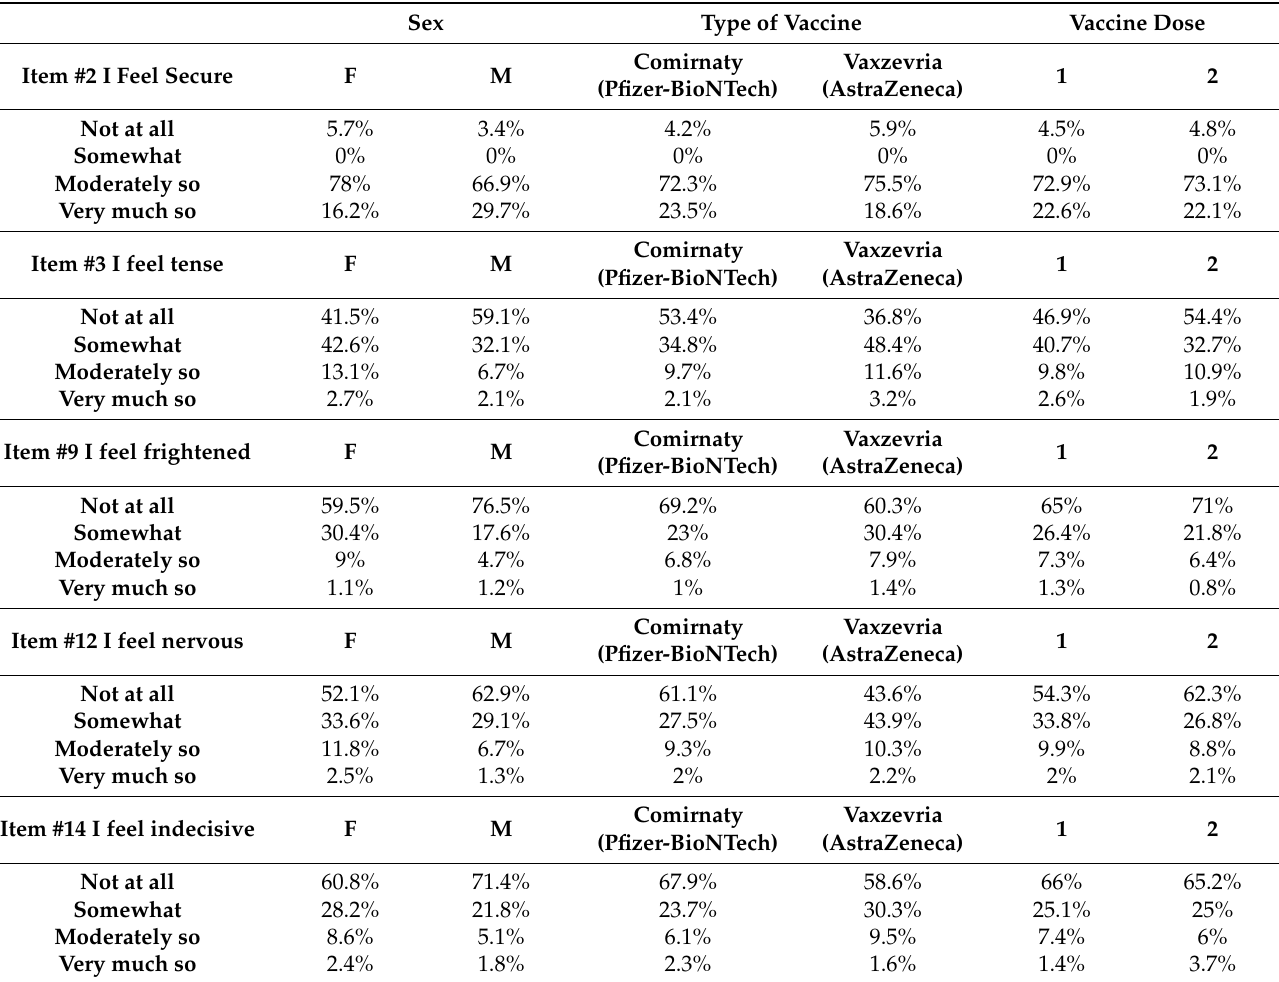
Table 6. Percentage of response frequencies related to the clinically significant items of STAI-Y divided by